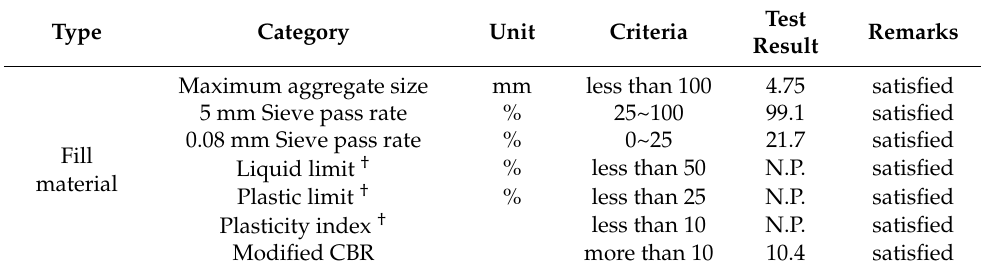
Table 6. Assessment of recyclability of remediated soil.